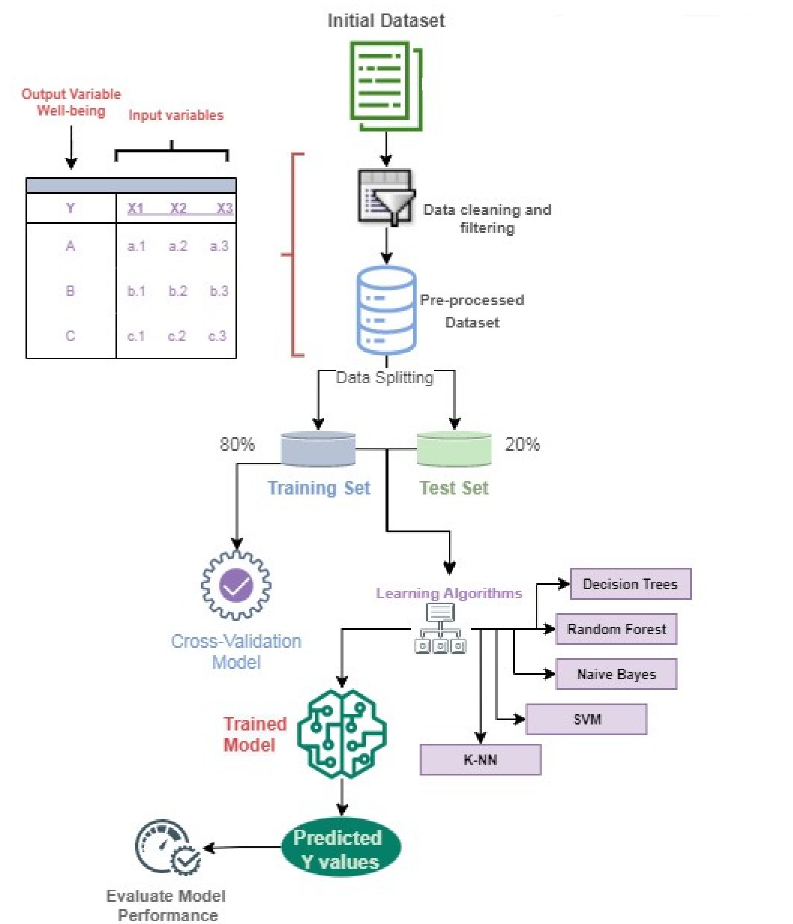
Figure 6. Process used for classification